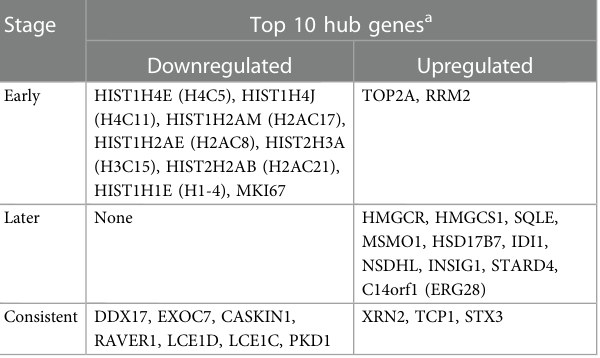
TABLE 1 Early (5 h), later (24 h) and consistent top 10 hub Genes. Corrections have been made to legend of FIGURE 3 because the upregulated and downregulated genes are reversed in position: FIGURE 3 Venn diagram. ( A ) Downregulated and ( B ) upregulated genes. FIGURE 5 PPI network at 5 h. ( A ) Entire network. Downregulated and upregulated genes are represented by red